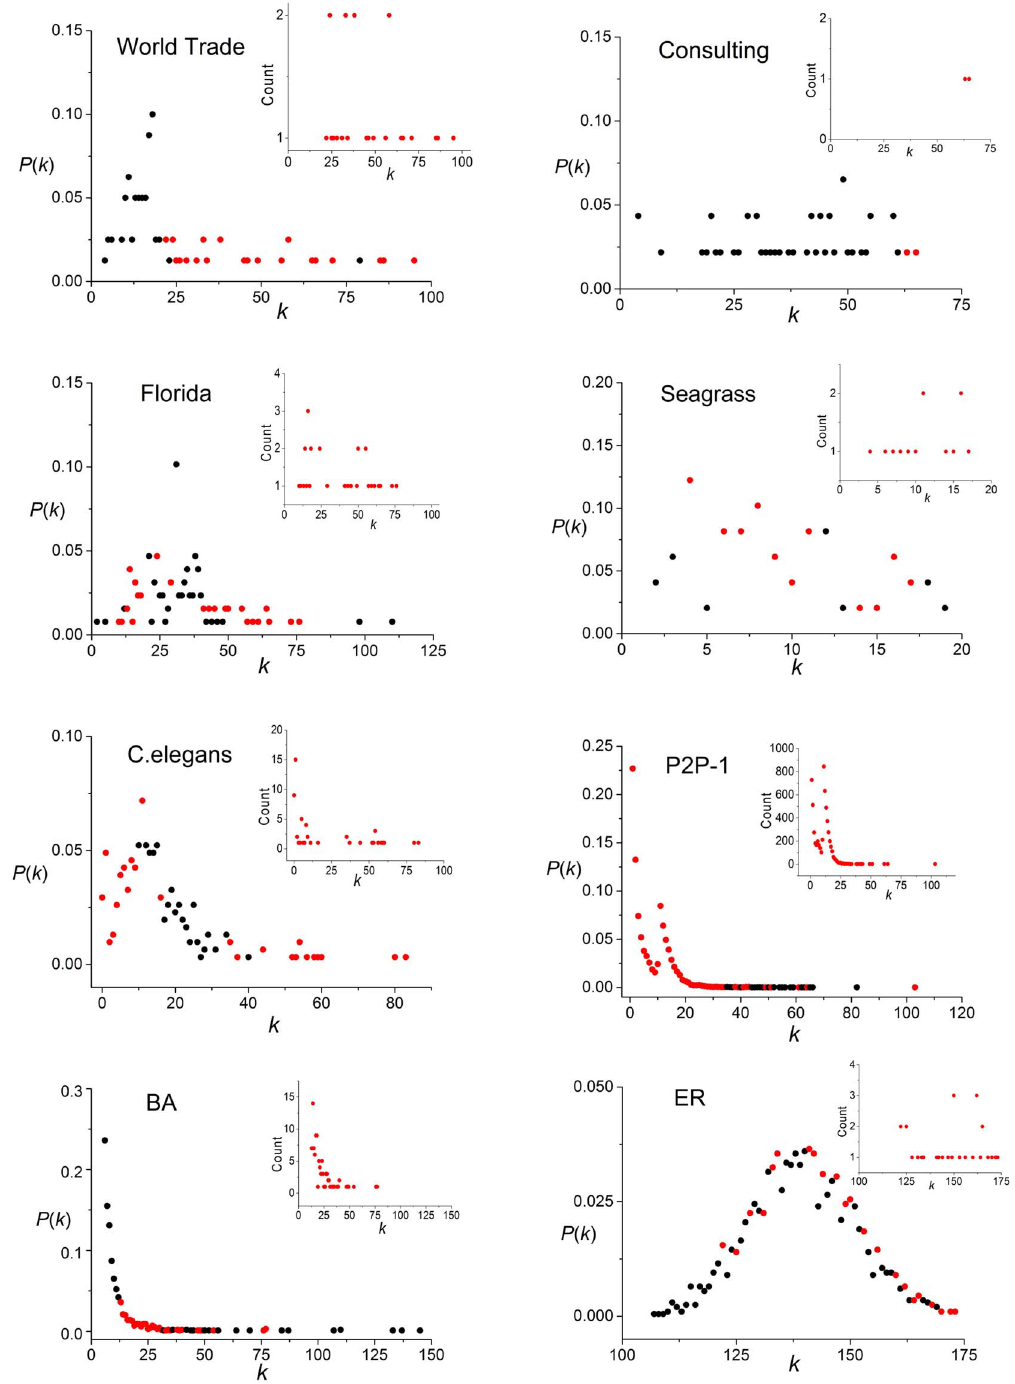
Figure 3. Degree distribution of driver nodes in real and model networks. The MDS with the highest average degree , k D max . was computed by using the preferential matching method. Each point corresponds to the set of nodes with the specific degree k , the black point means that no node with the degree k appeared in the result MDS and the red point means that some nodes with the degree k appeared in the result MDS. The inset graph shows the degree distribution of all driver nodes of the MDS with , k D max .